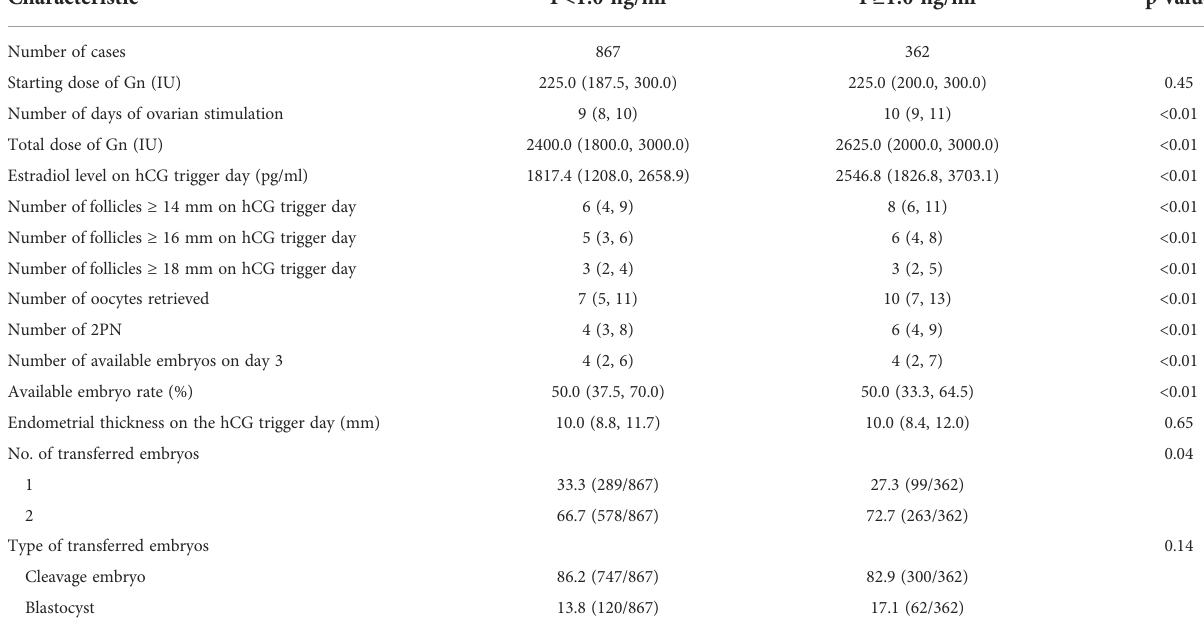
TABLE 2 Characteristics of controlled ovarian hyperstimulation cycles.